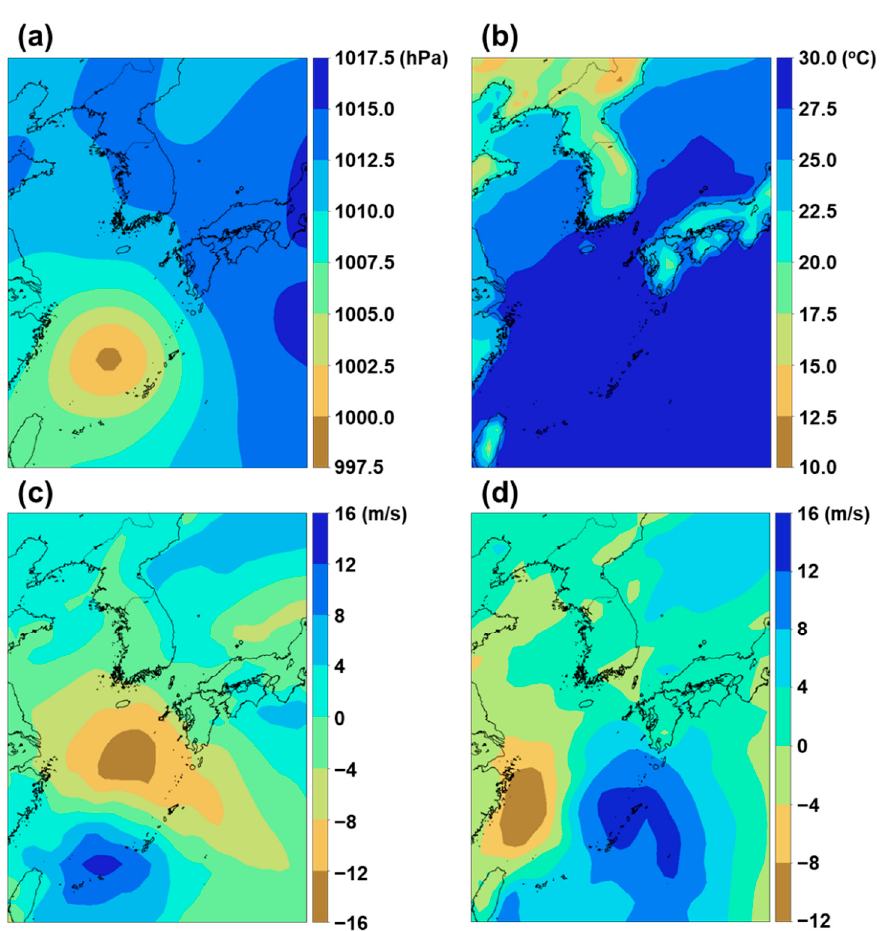
Figure 2. Global Forecast System (GFS) numerical weather model data. Mean sea level pressure ( a ), air temperature ( b ), and U and V component of winds ( c , d ) were used to train the artificial neural network.